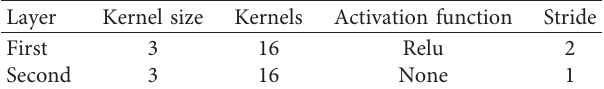
Table 1: Parameter table of Conv1D.